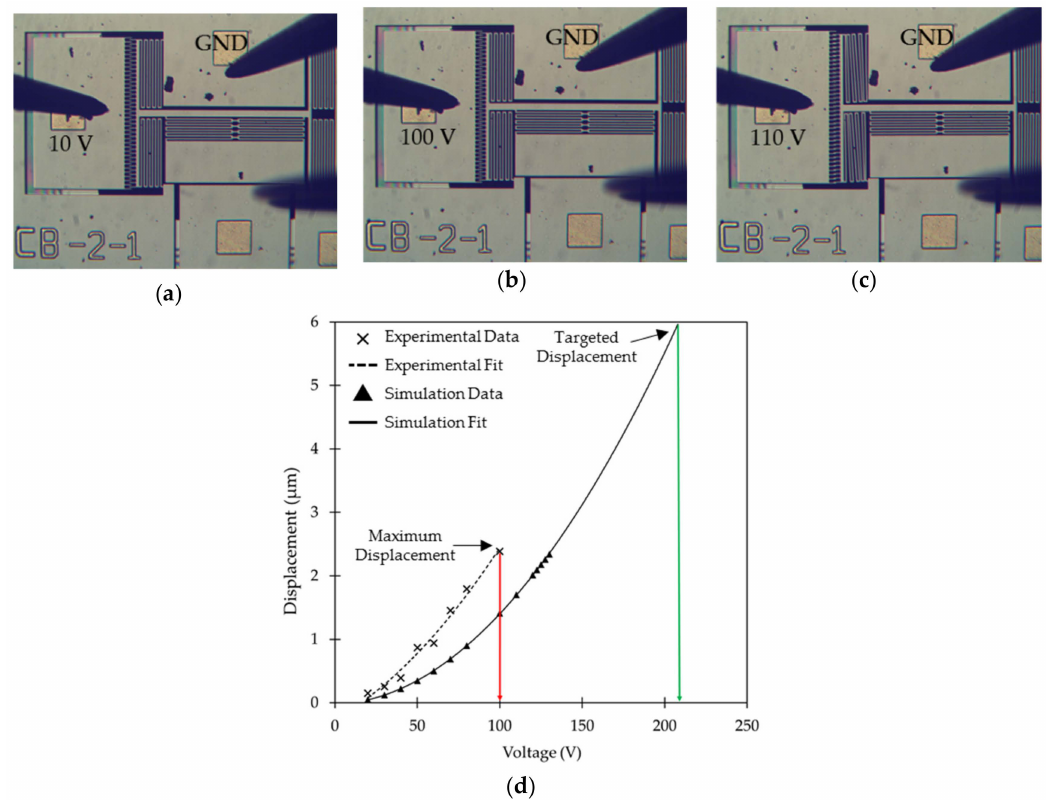
Figure 4. Microscopic micrographs of the translational MEMS platform with comb drive during actuation: ( a ) at 10 V; ( b ) maximum displacement at 100 V; ( c ) rotation at 110 V; ( d ) experimental and simulation based lateral switching displacement v / s actuation voltage curves for the translational MEMS design with comb drive.